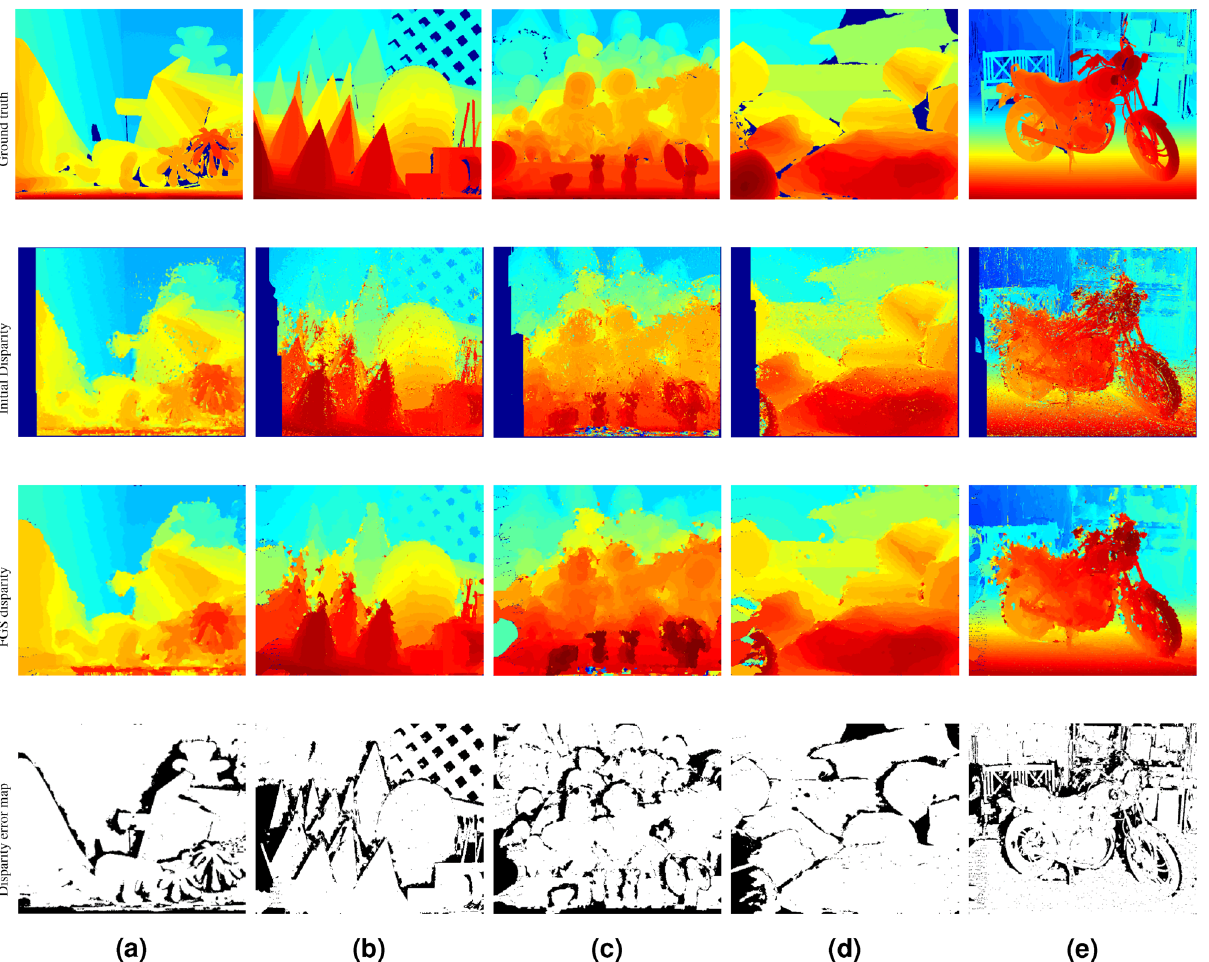
Figure 5. Estimated disparity maps and error maps for selected Middlebury stereo pairs without post- processing. ( a ) Teddy (dataset 2003), ( b ) Cones (dataset 2003), ( c ) Dolls (dataset 2005), ( d ) Rocks1 (dataset 2006), and ( e ) Motorcycle (dataset 2014). Disparity estimates in the occluded regions were not excluded in the final disparity maps. Initial FGS Images